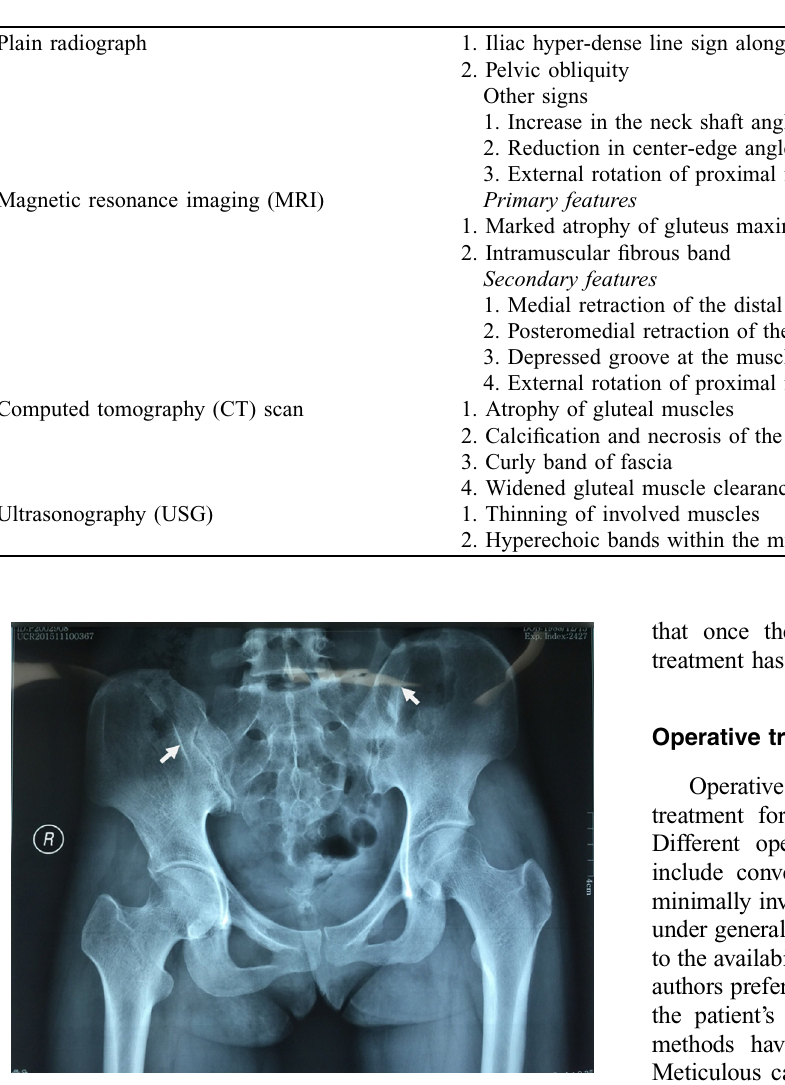
Figure 1. Anteroposterior radiograph of a patient with bilateral gluteal muscle contracture. The two arrowheads show iliac hyper- dense line over the bilateral posterior iliac spine with slight pelvic inclination toward the